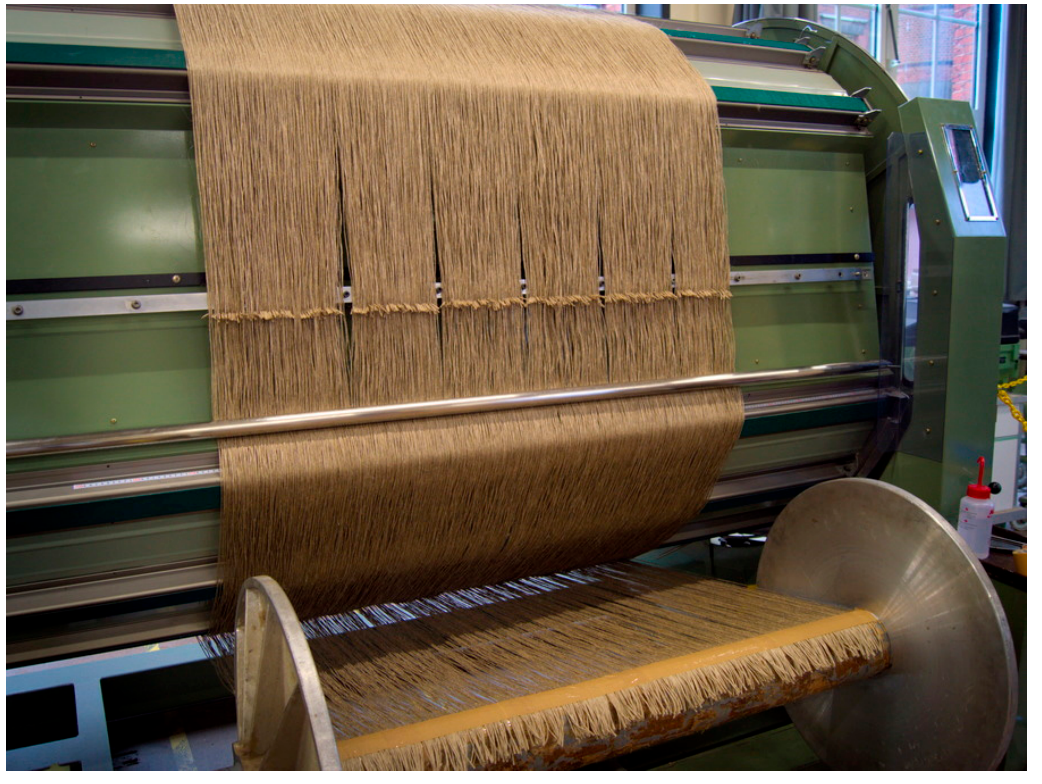
Figure 2. Stuffer warp yarns beam on sample warping machine. Figure 2. Stu ff er warp yarns beam on sample warping